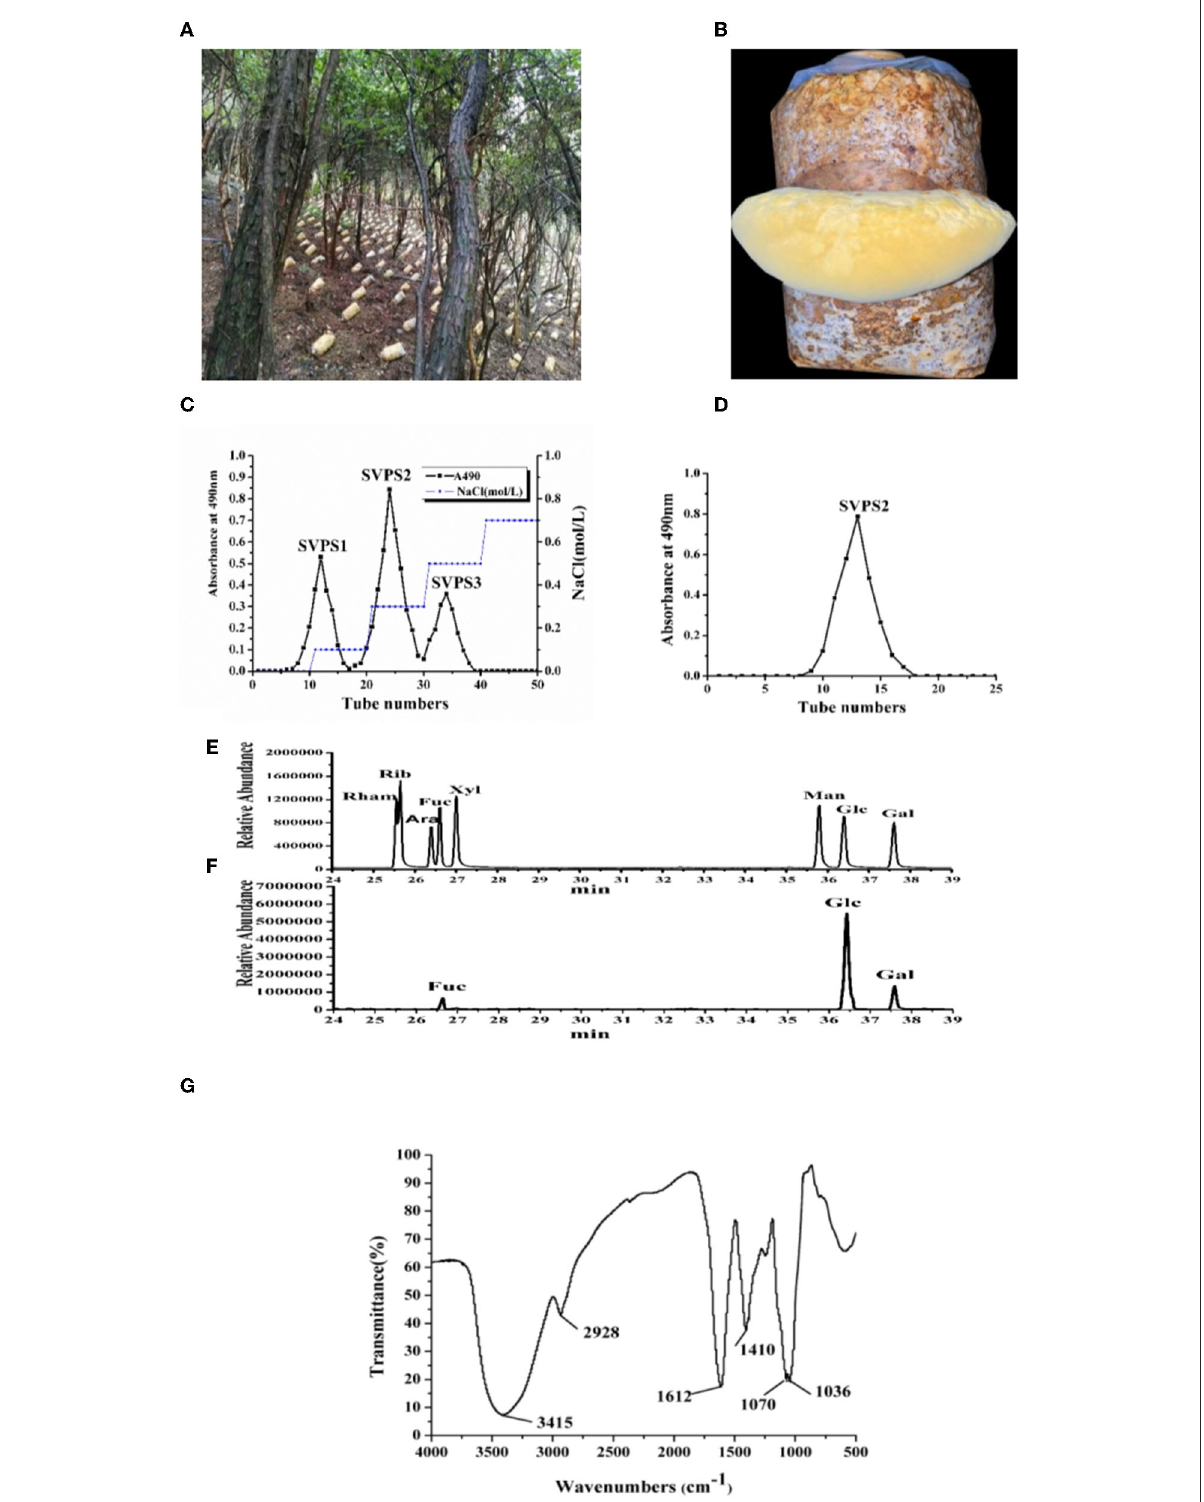
FIGURE1 The on-site picture of cultivated fruiting bodies (A) and the enlarged part of S. vaninii in forest (B) . The profile of crude polysaccharides eluted on DEAE-Sepharose Fast Flow column (C) and the purified SVPS2 fraction by Sephacryl-S 100 column (D) . The GC-MS results of standard sugars (E) and PMP-derived SVPS2 (F) . IR spectrum (G)